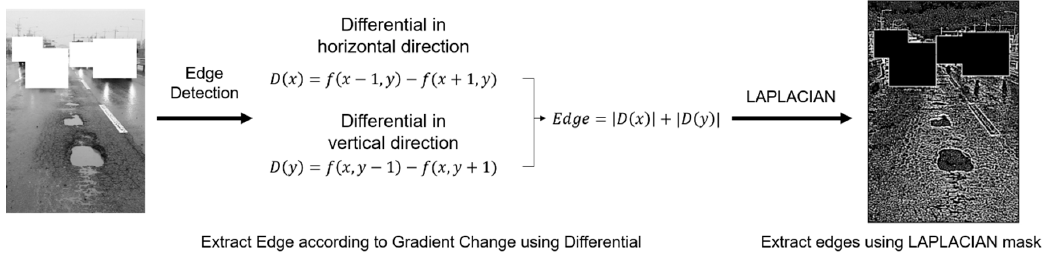
Figure 3. The process of extracting features of road damage using edge detection.